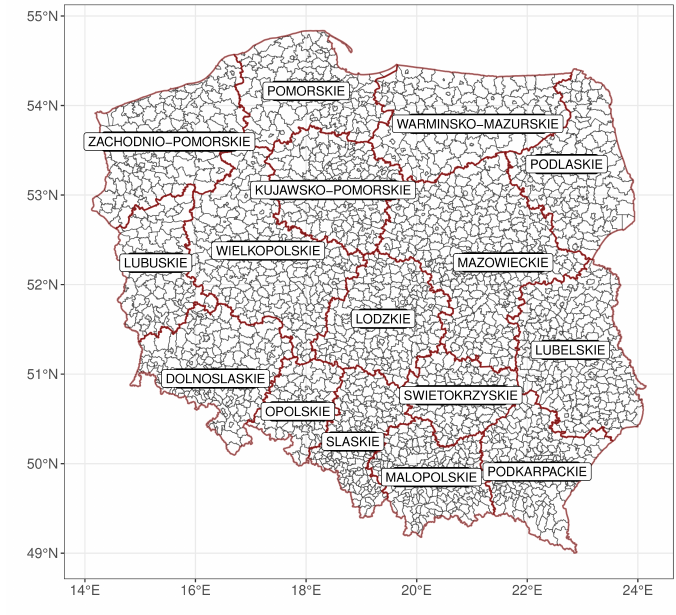
Figure 2. Administrative divisions of Poland for which crop yields were predicted: Nomenclature des Unités Territoriales Statistiques level 2 (NUTS-2)—red lines, and Local Administrative Units (LAU)—gray lines.